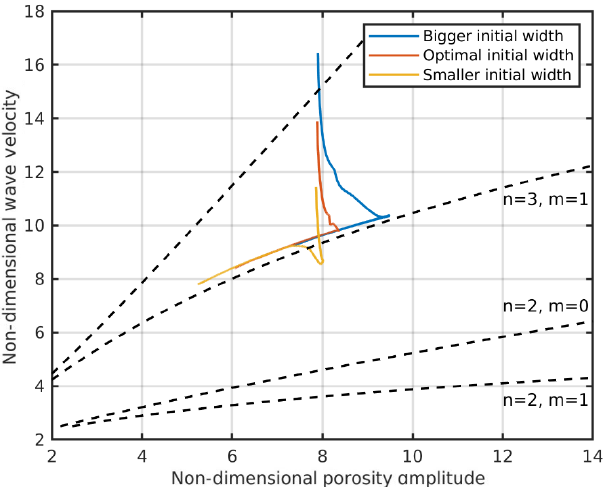
Figure 4. Dispersion curves for 44 models with four different initial amplitudes (4 to 10) and 11 different initial widths each. All models were carried out for a melt network geometry consisting of 100% films with an aspect ratio of